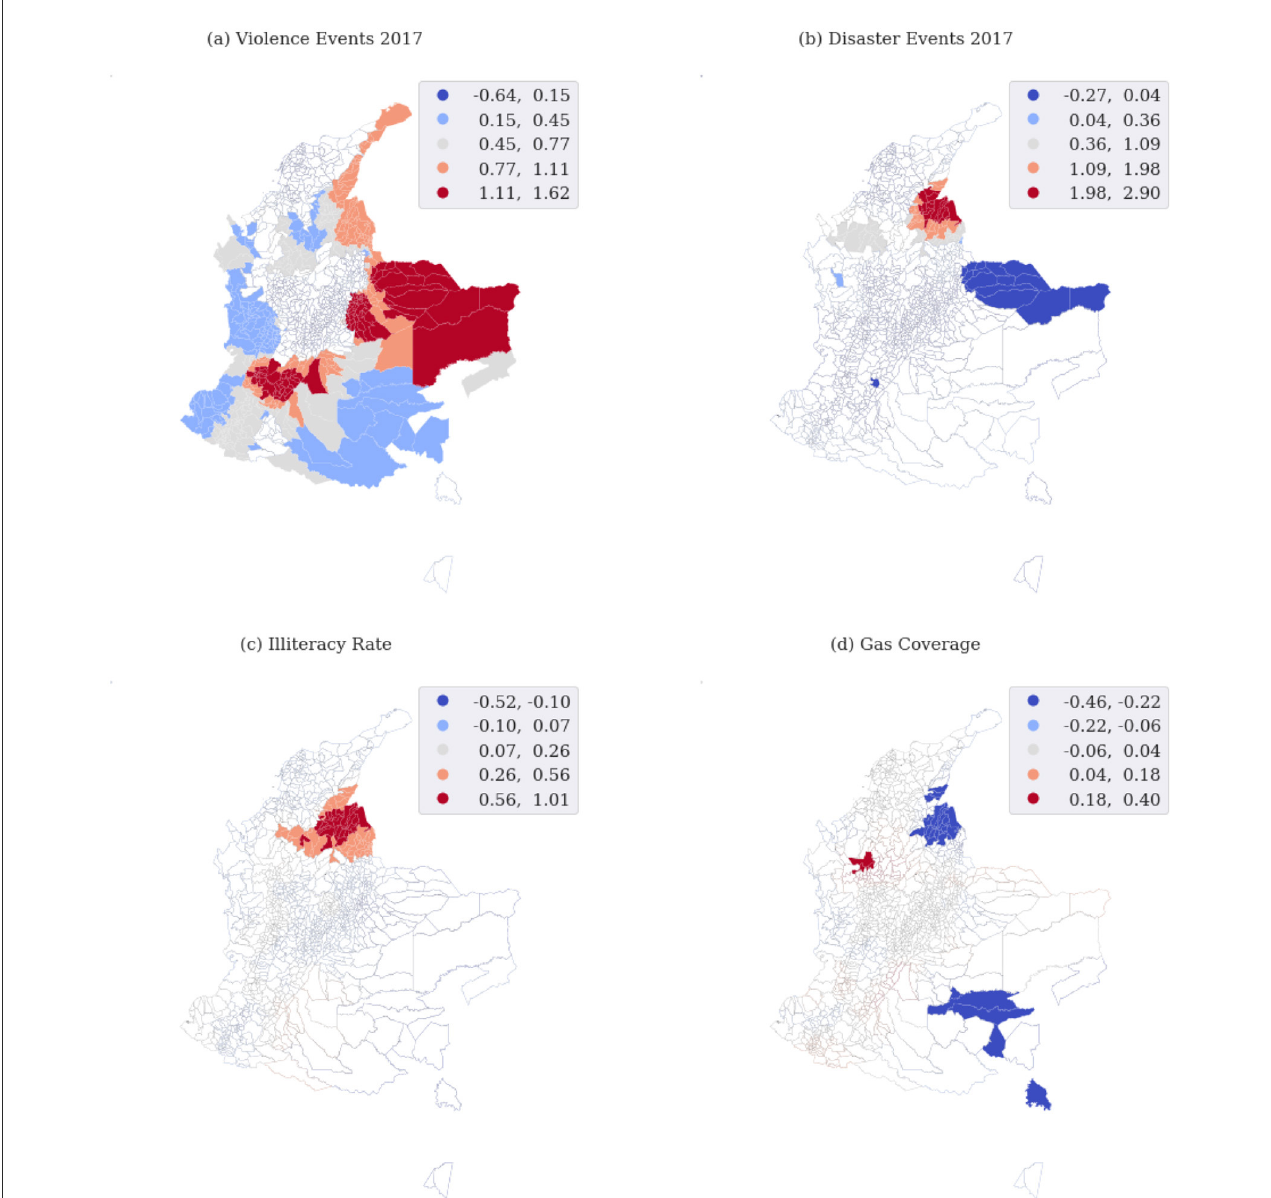
FIGURE8 Geographically weighted regression model results: the maps show areas where the local parameters have significant local t -values and significant p